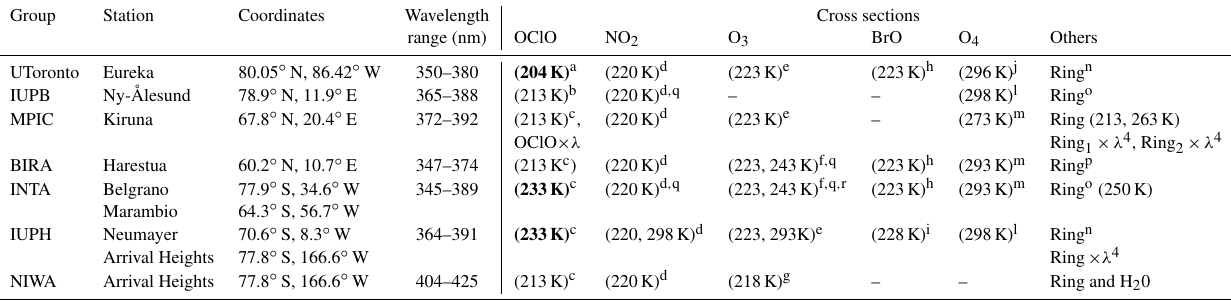
Figure 3. Geographical distribution and measurement time periods of the UV–VIS NDACC ZSL-DOAS instruments providing the correlative OClO measurements. Table 2. Description of the different ground-based OClO datasets used in this study. Dashes are used to indicate instances where data were not